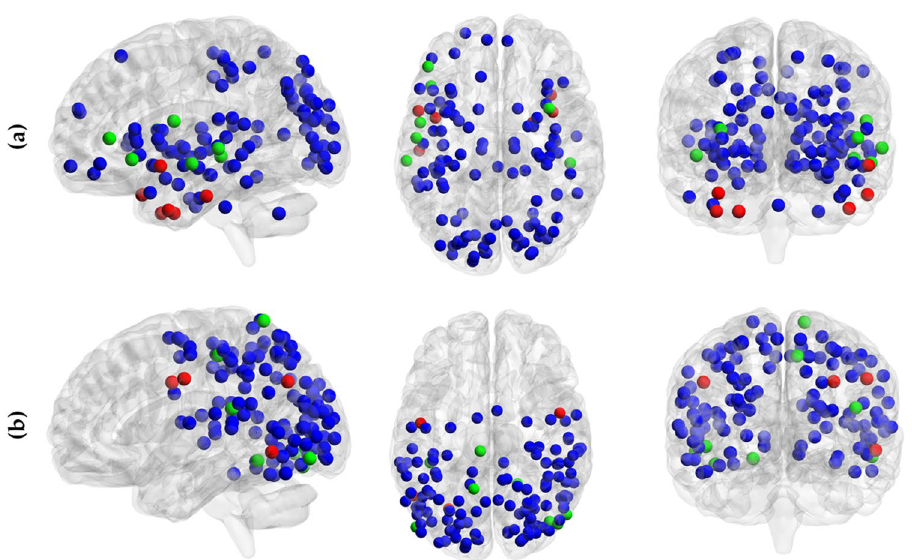
Figure 3. Rich club organization of ( a ) structural networks and ( b ) functional networks for cannabis users and healthy controls. The common rich club nodes in two groups are shown in blue. Few rich club nodes were only found for healthy controls (in red) or cannabis users (in